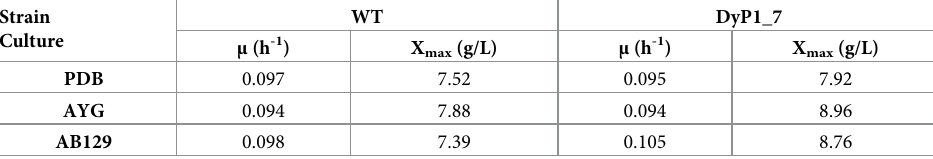
Table 2. Growth parameters of the WT and TaDyP1_7 strains in liquid culture.